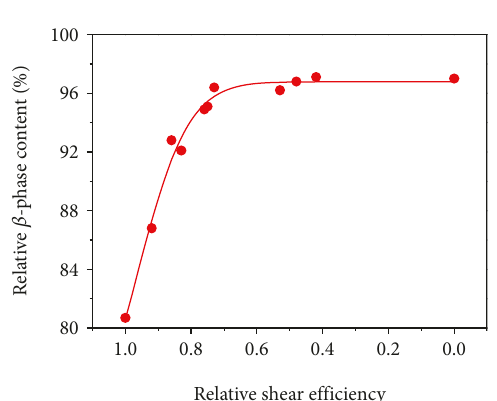
Figure 8: WAXD patterns of β -nucleated iPP relaxed at 170 ° C for di ff erent times after shearing ( shear rate = 40s − 1 , shear time = 10s , and T S = 170 ° C ).